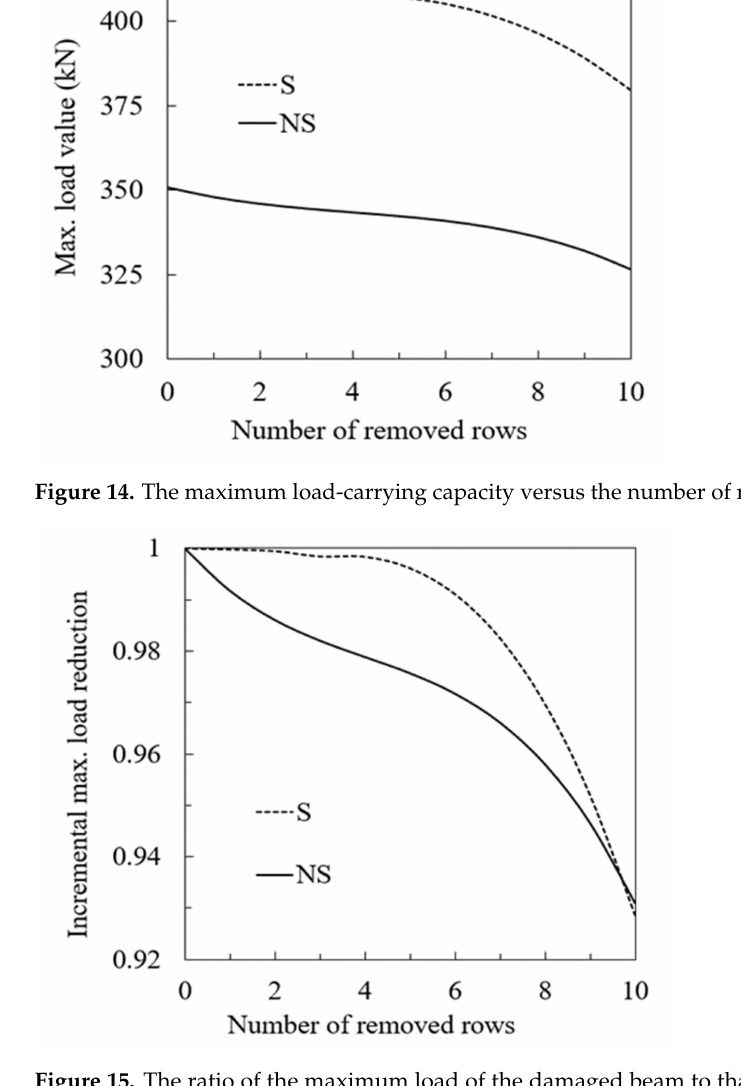
Figure 15. The ratio of the maximum load of the damaged beam to that of the un-damaged beam versus the removed row